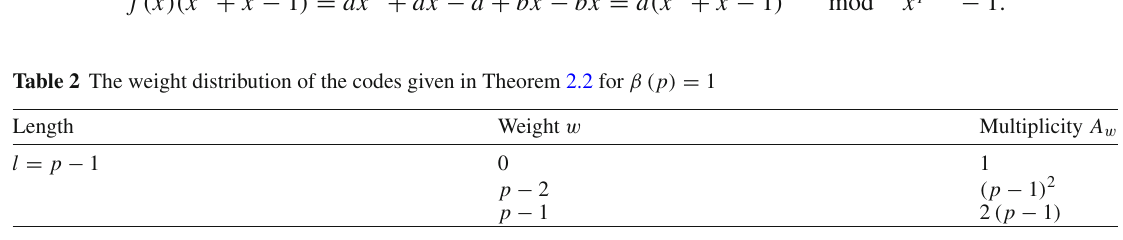
Table 3 The weight distribution of the codes given in Corollary 2.5 and Theorem 2.6 for β ( p ) = 2 Length Weight